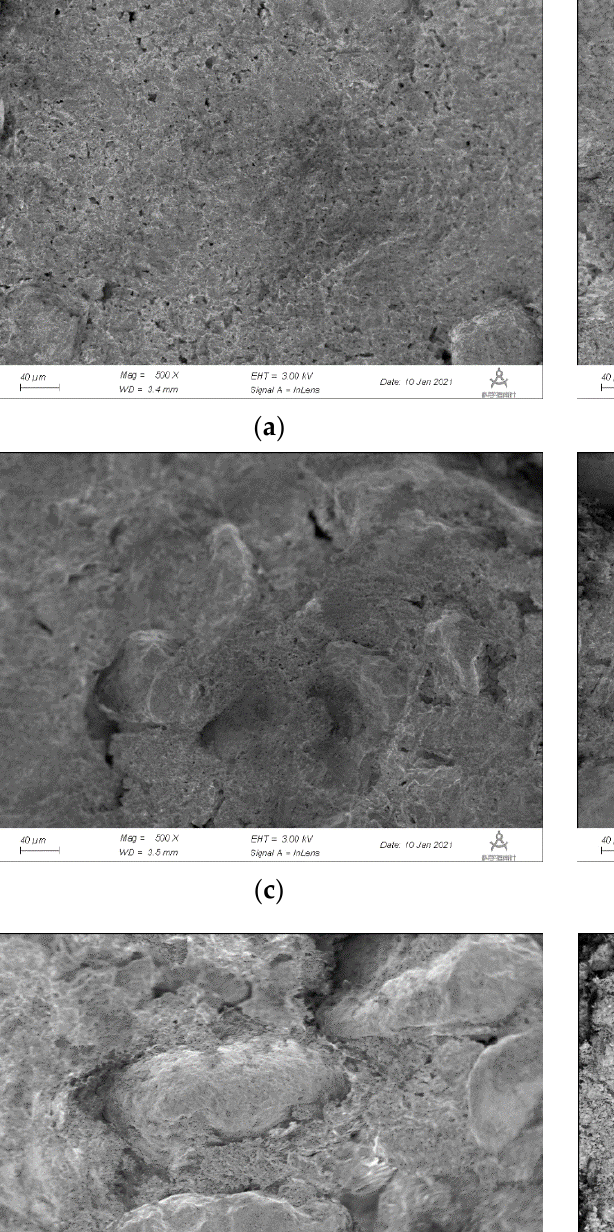
Figure 7. Void statistics. (a—400 W 200 min, b—400 W 300 min, c—1200 W 120 s, d—1200 W 240 s, e—2000 W 80 s, f—2000 W 120 s.) Fourth, overall stable stage (d–e): When entering this stage, as seen in Figure 5, the variations in moisture content and temperature further slowed down, and the influence of moisture content on the material strength further weakened. At this stage, the moisture content had reached a reasonably low level, so the ability of the sample to absorb micro- waves at this stage was fragile. As a result, the temperature of the sample increased slowly, and the temperature difference at each point of the sample became minimal, re- sulting in the slight effect of thermal stress on the material strength. Similarly, due to the extremely low water content, the steam explosion effect in the material was non-existent. Therefore, the impact of the steam explosion did not affect the material strength at this time. Therefore, the material strength at this stage remained unchanged regardless of the curing power. Thus, at this time, the cured material had reached stable strength under the curing condition. 3.3. Irradiation Condition Control Method of Microwave-Cured Analog Materials The previous section proved through experiments the pattern of material strength variation versus microwave curing time under different power conditions, and compared the magnitude relationship of the strength at each stage under other power conditions. We concluded that the higher the microwave power, the more violently the material strength increased and the shorter the time it took to complete a strength development stage. However, no matter the stage of variation, the higher the power, the lower the ma- terial’s strength was. Figure 8 shows the comparison between the stable material strength